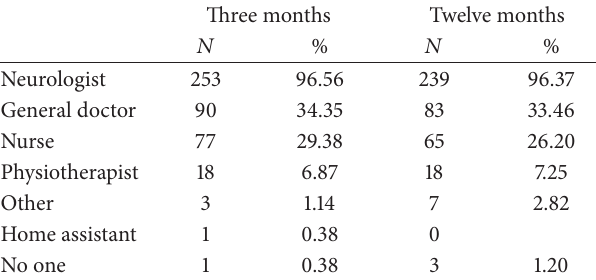
Table 2: “Which health professional is mostly involved in MS management?” (multiple answers